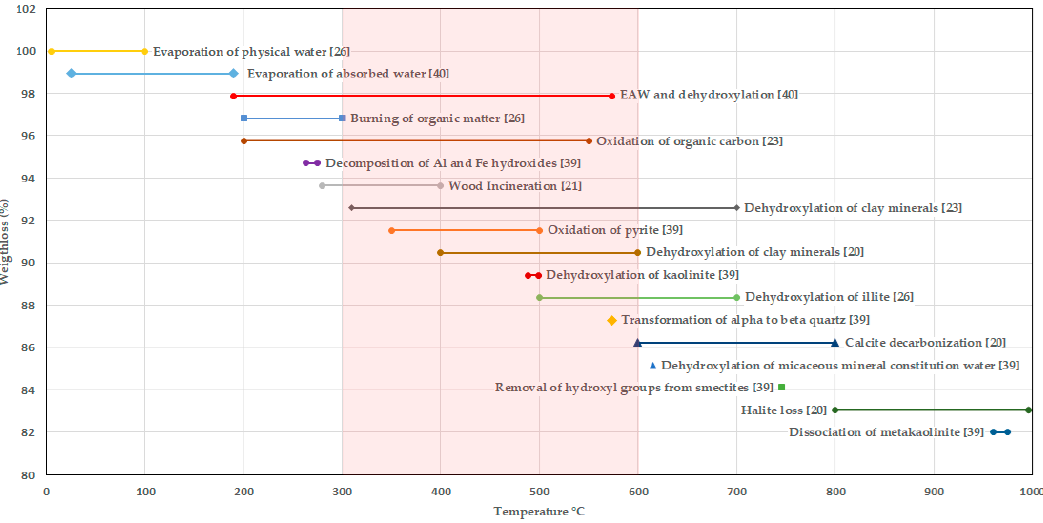
Figure 9. Weight loss ranges for different materials due to the increase in the temperature of ceramic matrices. Data from [20,21,23,26,39,40].